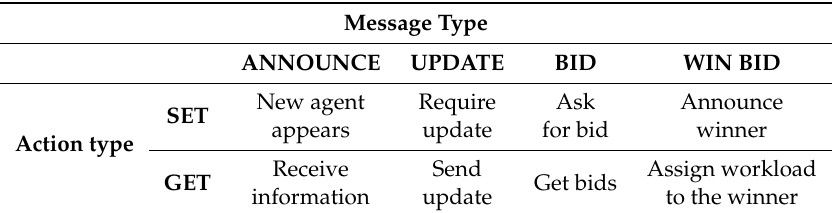
Table 2. Inter-agent communication messages in